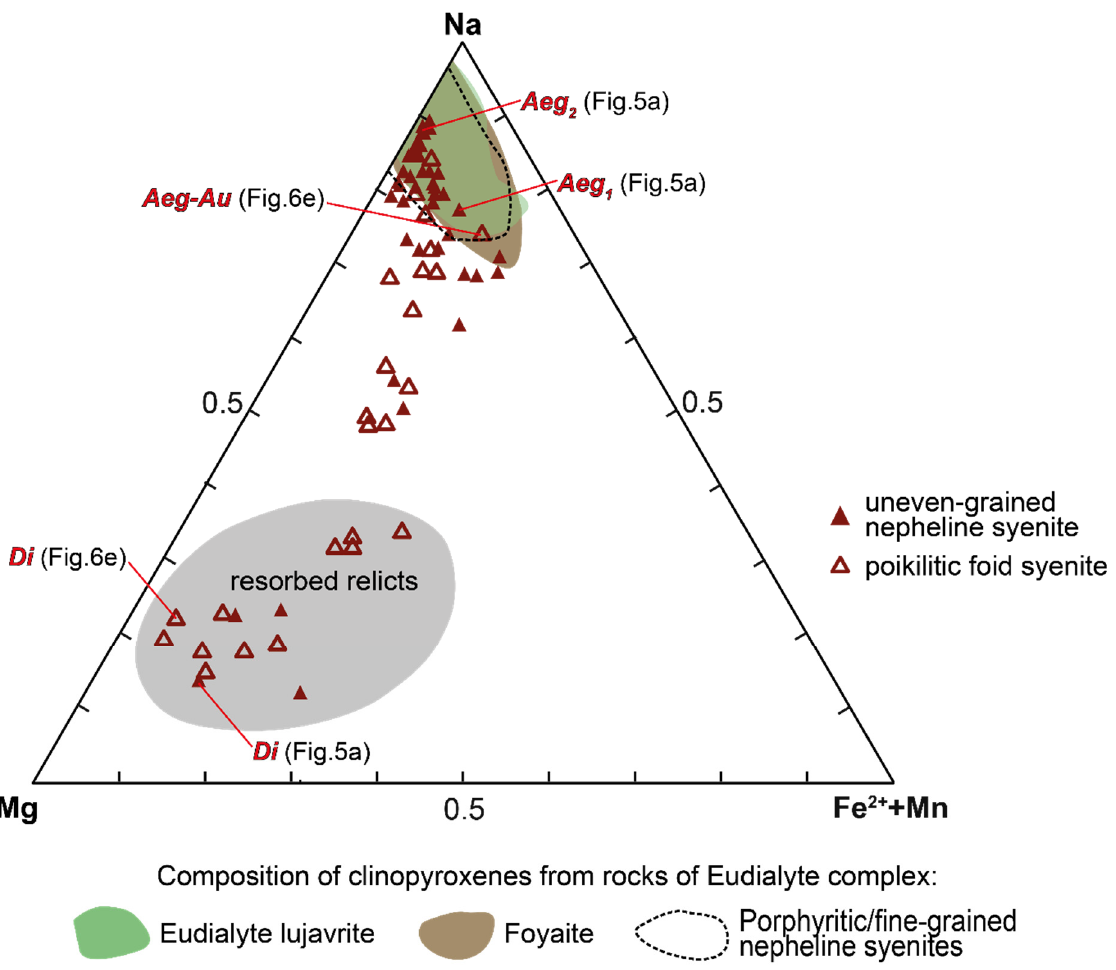
Figure 12. Mg–(Fe 2+ +Mn)–Na systematic of clinopyroxenes from poikilitic rocks. The compositions of clinopyroxenes from the rocks of the Eudialyte complex (adapted from [54]) and composition of resorbed relicts of Ca–Mg-rich clinopyroxenes are denoted by colored backgrounds and a dashed line.